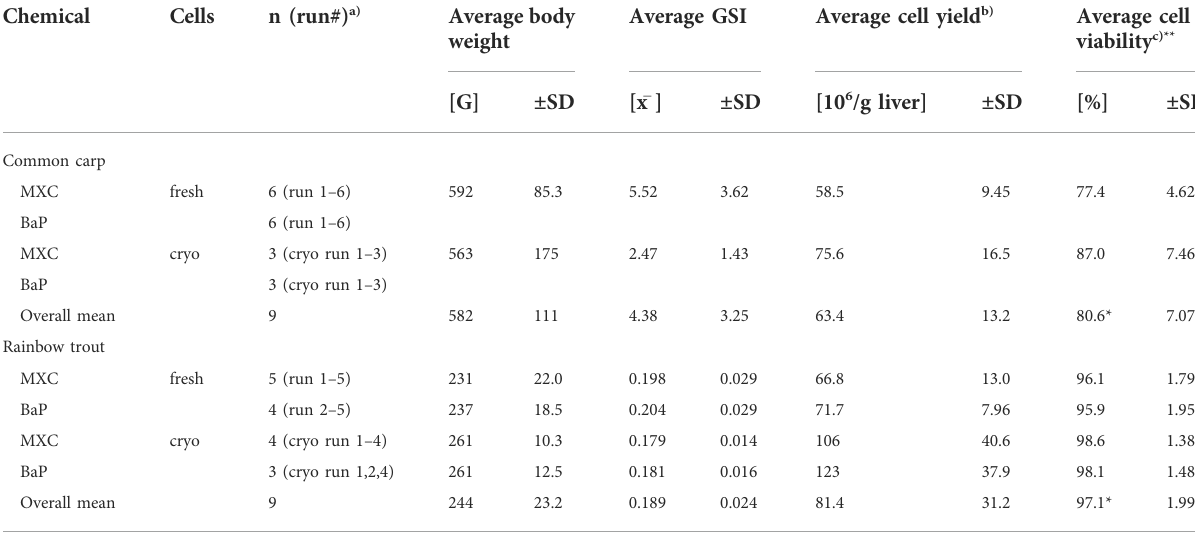
TABLE 1 Overview of the in vitro assays: Characteristics of hepatocyte donor fi sh and quality of cell isolation. Chemical Cells